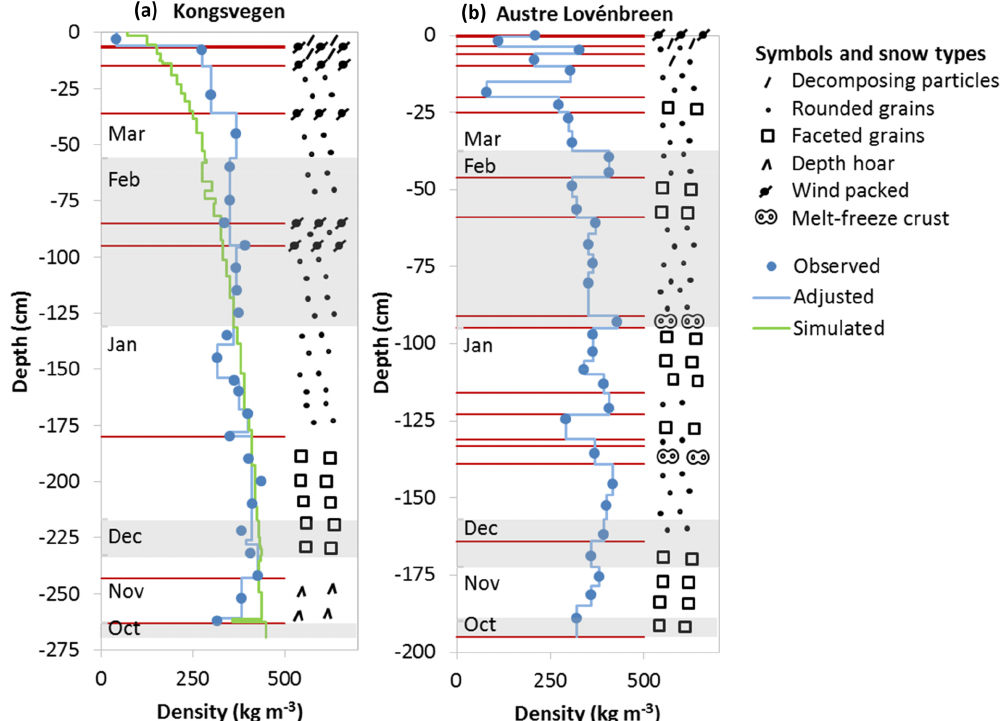
Figure 2. Snow stratigraphy observed in the snow pits KV (a) and AL (b) . Note the different depth scales. Snow types are indicated on the right side using the classification recommended by Fierz et al. (2009), with layers separated by horizontal red lines. Blue circles indicate observed snow densities, and vertical blue lines correspond to snow densities adjusted to observed and sampled layers. The green line shows snow densities simulated with the CROCUS model for snow pit KV. The alternating shaded and non-shaded areas correspond from the top to the months March to